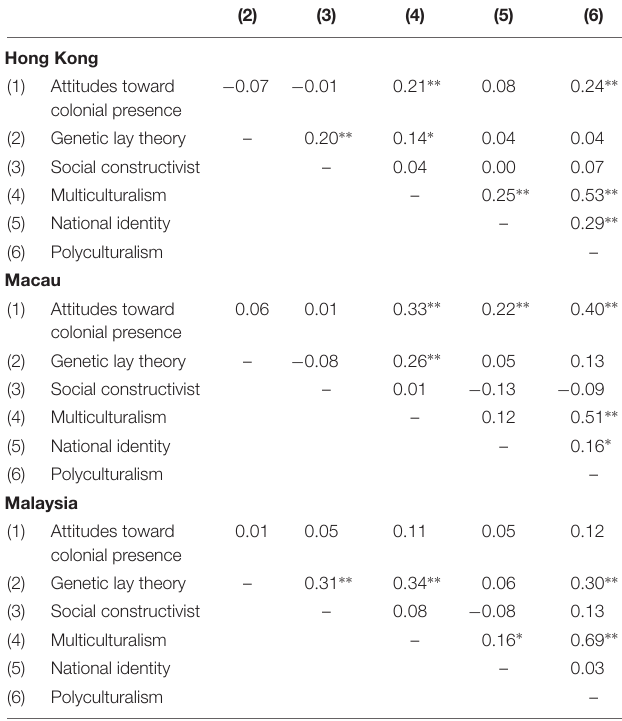
TABLE 2 | Correlations among key variables for three Asian